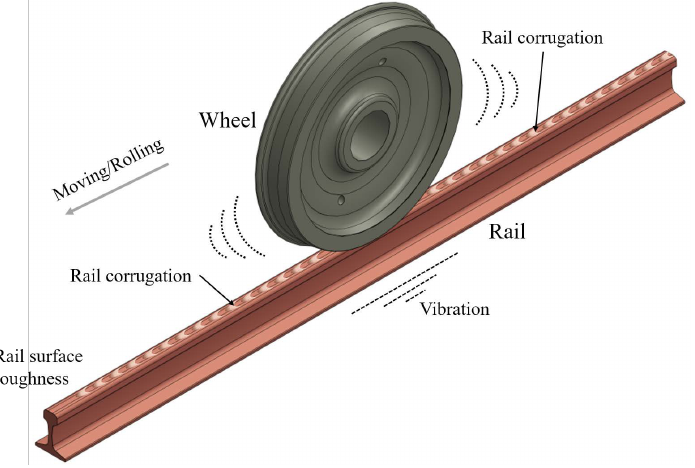
Figure 1. Rail corrugation and rolling noise generated through wheel-rail contact